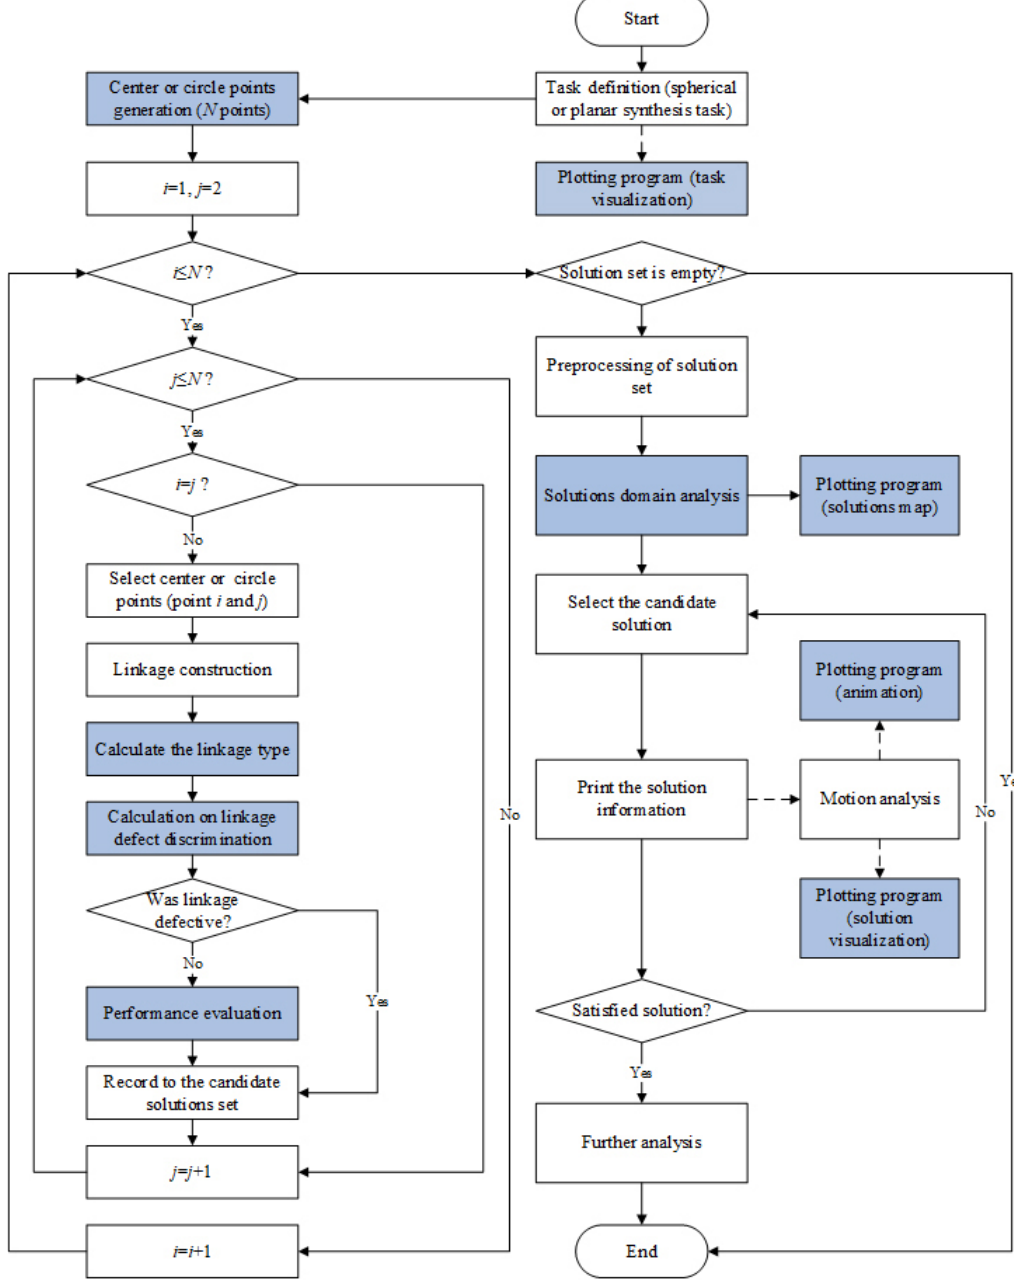
Figure 1. The flow chart of the linkage synthesis calculation.